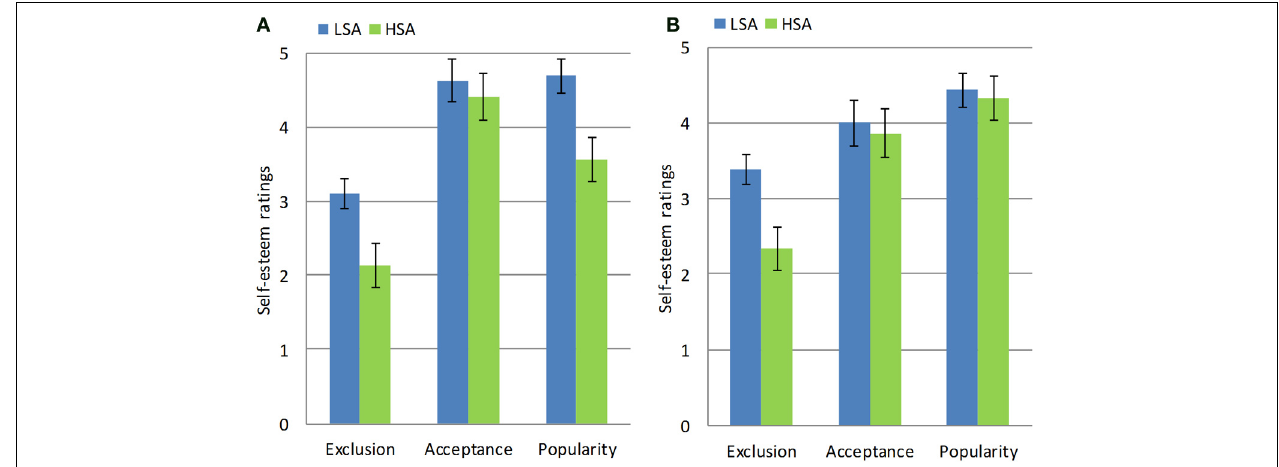
FIGURE 1 | Self-esteem measures of women (A) and men (B) in the high and low social anxiety groups following exclusion, acceptance, and popularity manipulations. Error bars represent standard errors of the